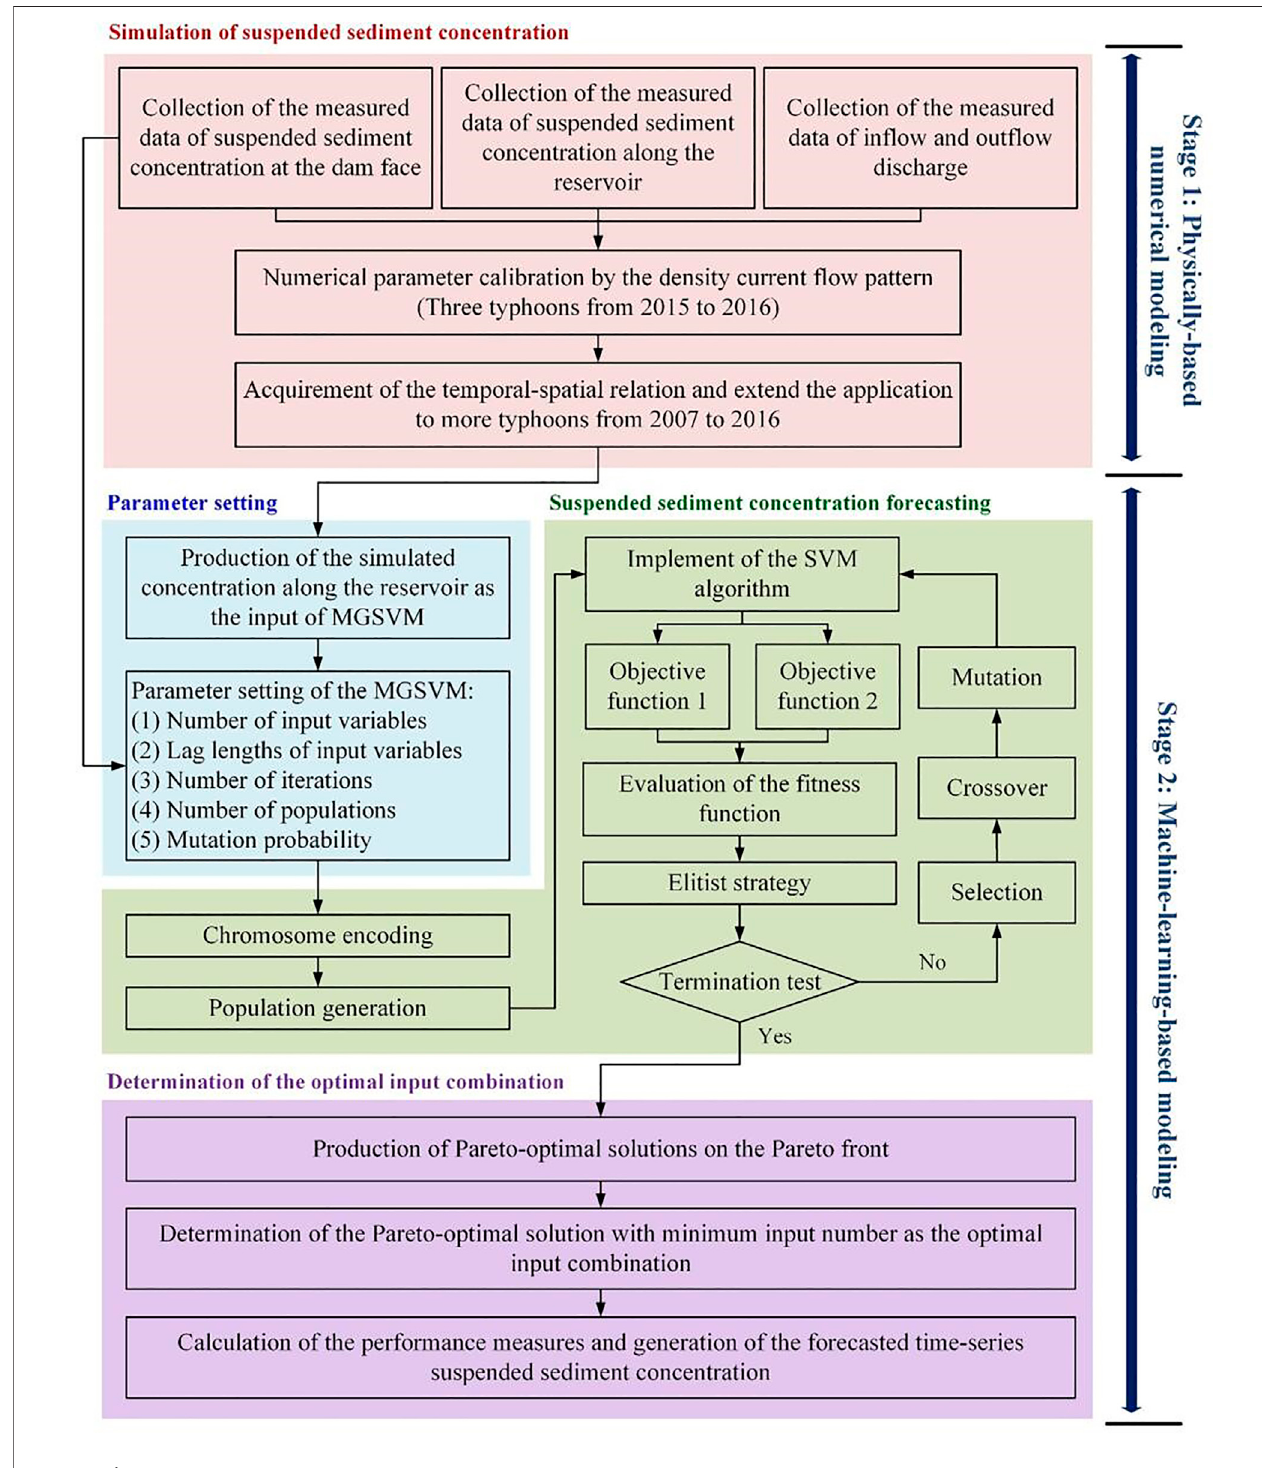
FIGURE 7 | Flowchart of the two-stage forecasting approach integrating numerical and machine-learning-based models (Huang et al., 2019).